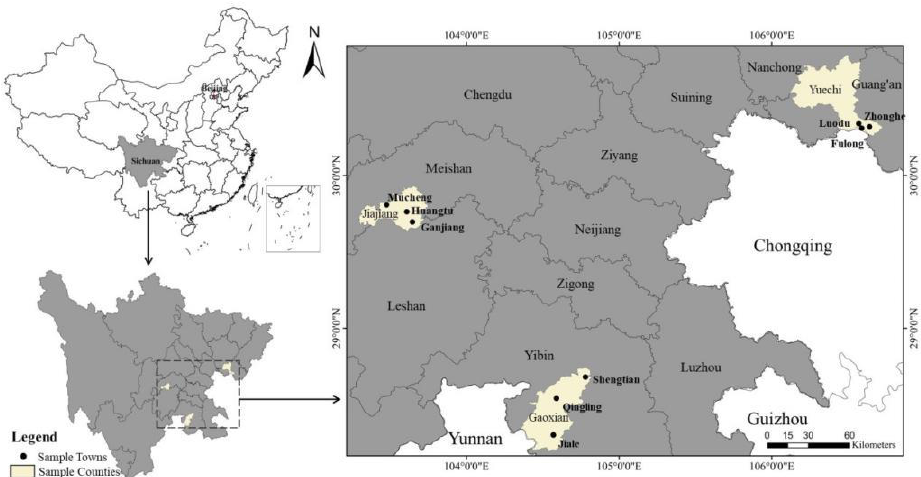
Figure 1. Distribution map of sample area.